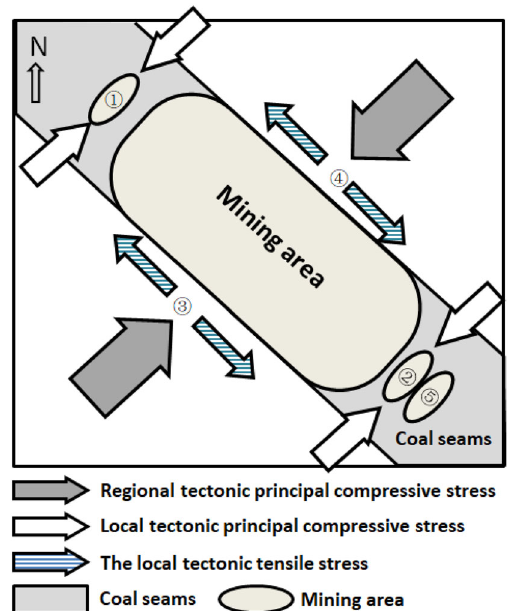
Fig. 15 Geological model of tectonic stress disturbances over a mining area leading to coal mine disasters (stress: with value changed solely, direction